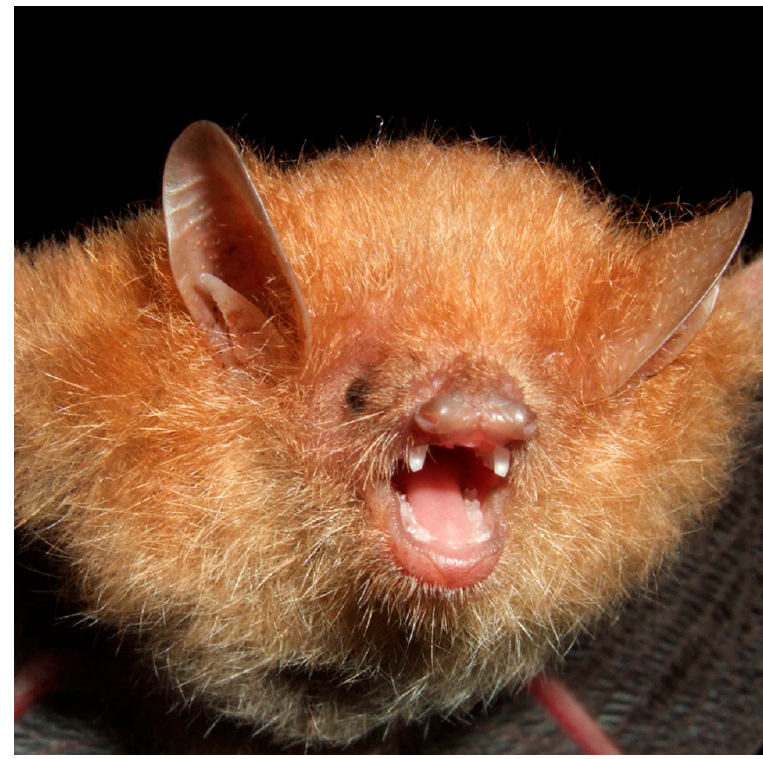
Figure 17. Murina cyclotis , adult male. Photograph by Vu Dinh Thong.